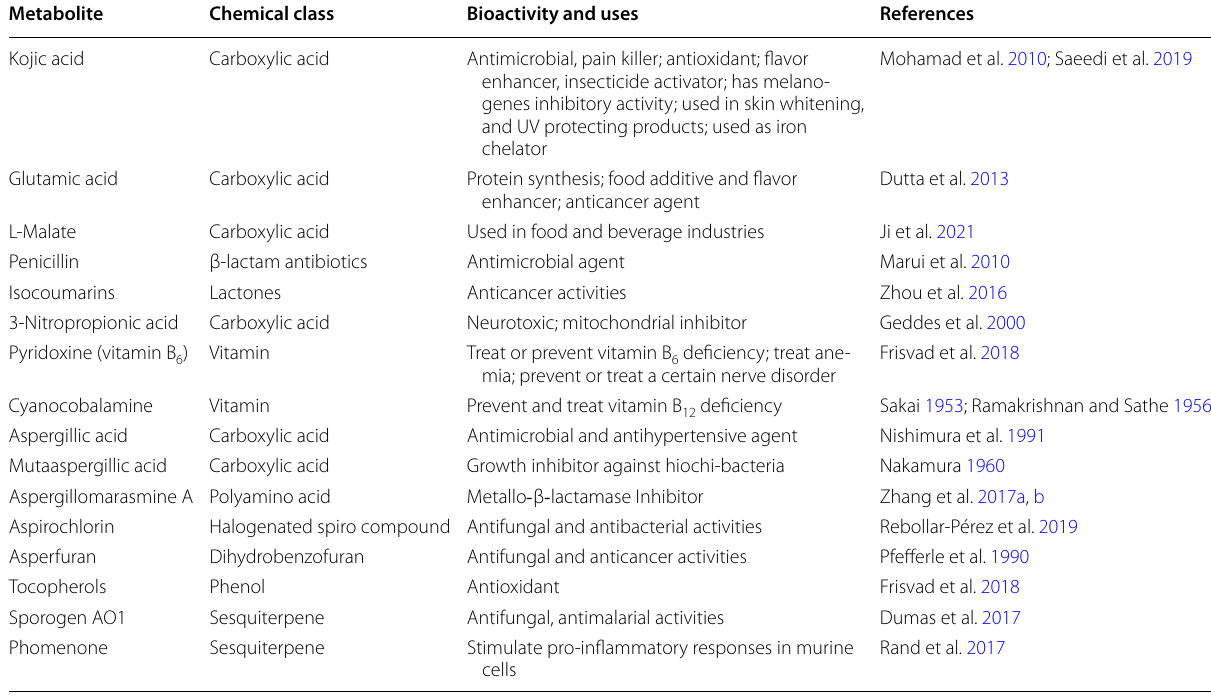
Table 2 Some secondary metabolites produced by A. oryzae and their biological activities Metabolite